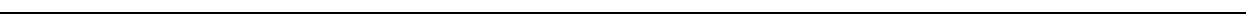
Fig. 3 New forming contact regions at microvilli tips. a (left) A topographic image of the cell is provided by AFM Quantitative Imaging (QI TM ), exploiting the contact point z position in each pixel. (middle) A topographic image of small feature up to 200 nm is extracted after local smoothing (see Methods, Topography for details). (right) A contour analysis of the image in a (middle) comprising 100 contour lines with 2 nm step size. Scale bar 1 µ m. b Mean value diameter (black circles) of the contour lines from the previous panel. Broadening represents the STD. Colour-coding as in a (middle; red represents high features of 200 nm and dark blue represents low features). Dashed line mark the position where the derivation of this function is zero, representing the head of the microvilli. c Topographic image of a simulated thermal fl uctuating membrane with rigidity value of ~100 pN nm. Colour-coding identical as in a (middle). Inset shows the contour analysis. d Mean value diameter (black circles) of the contour lines analysed for the thermal fl uctuating membrane. Broadening represents the STD. Colour coding is identical to the one used in a (middle). Inset shows enlargement of the area selected. e Two-colour SMLM, PALM combined dSTORM of Jurkat cells expressing TCR ζ – Dronpa (green) and CD45 immunostained with Alexa647 (red) spread on an anti-CD3- coated coverslip 4 min before fi xation. Scale bar 2 μ m. f Zoom on a region containing a TCR cluster in e . Top view (upper panel) and side view (bottom panel) are presented. g The intensity pro fi le across the white line in f . h Histogram of z heights of detected molecules in f . TCR represented by full green bars and CD45 by empty red bars. i Upper panel, time sequence (at 4, 10, 40 and 60 s) of the synapse formed in between Did fl uorophore membrane tagged Jurkat cell and anti-CD3-coated coverslip. Lower panel, zooming into the distinct area selected with convex envelope surrounding the membrane molecules. Scale bar 0.5 μ m. j Convex envelops diameter of distinct areas ( n = 24) as a function of spreading time. t 0 is set as the appearance time